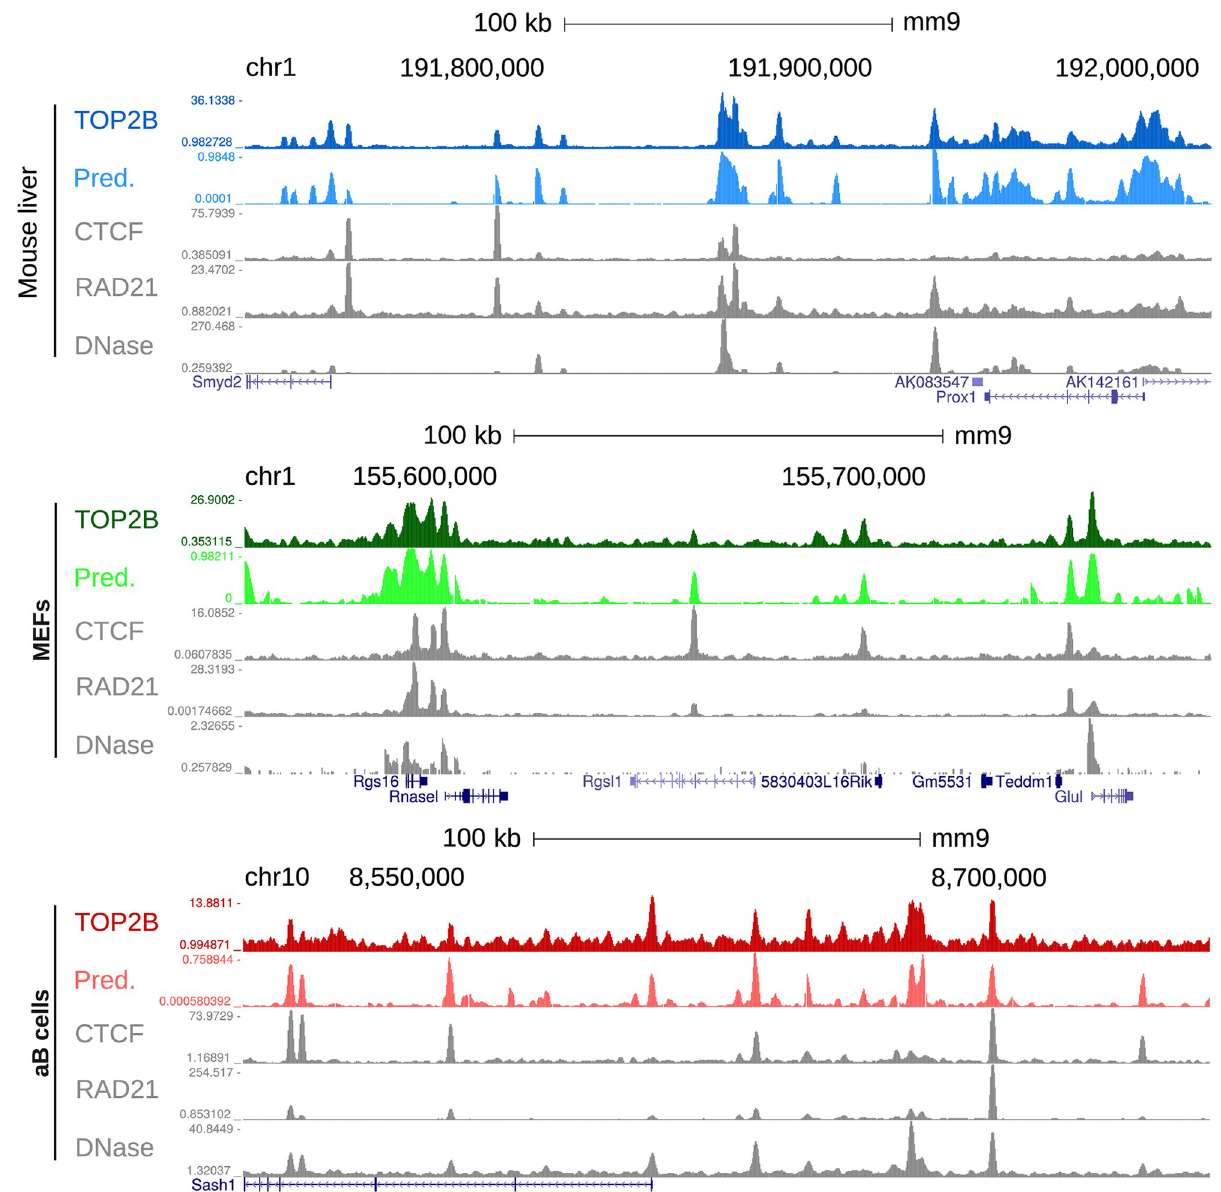
Fig 5. TOP2B predictive and experimental tracks in mouse liver, MEFs and activated B cells (training systems). From top to bottom, genome browser view of TOP2B ChIP-seq, TOP2B virtual track, CTCF ChIP-seq, RAD21 ChIP-seq and DNase-seq are displayed for each